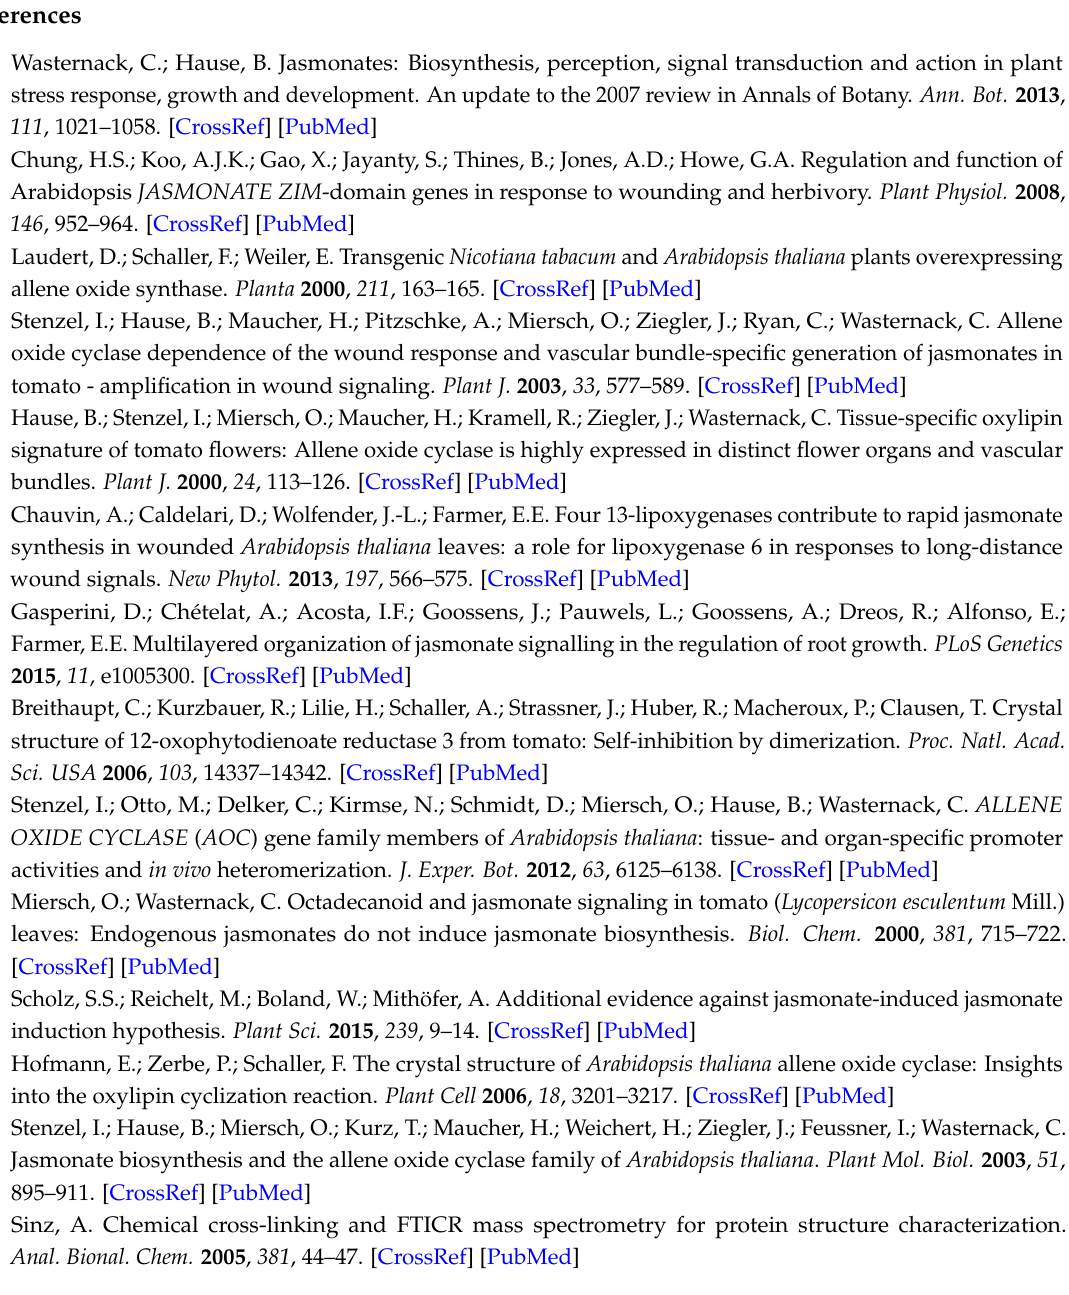
Figure S1: Determination of the multimerization state of AOC2 by size exclusion chromatography (SEC). Figure S2: Surface representation of the AOC2 trimer (back-side of Figure 1A). They can be accessed at: